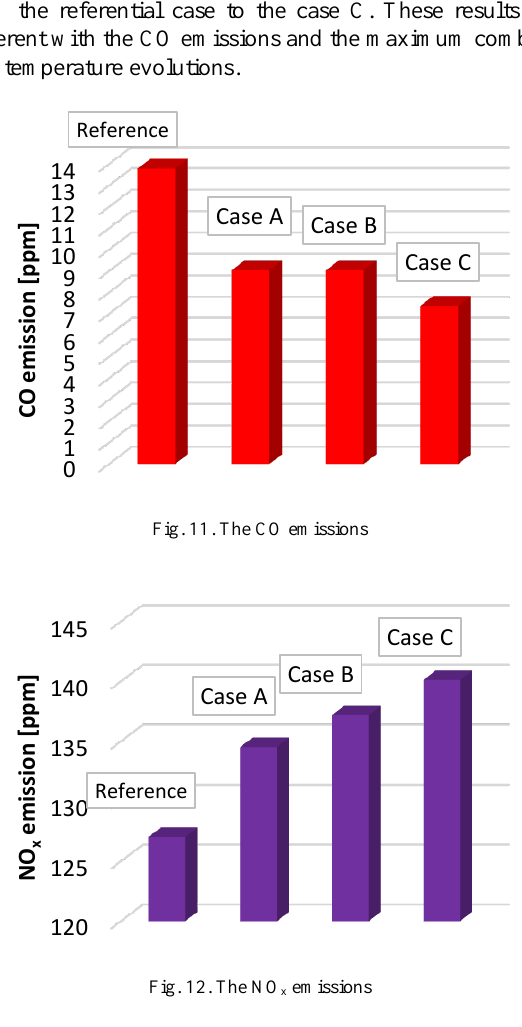
Fig. 12. The NO x